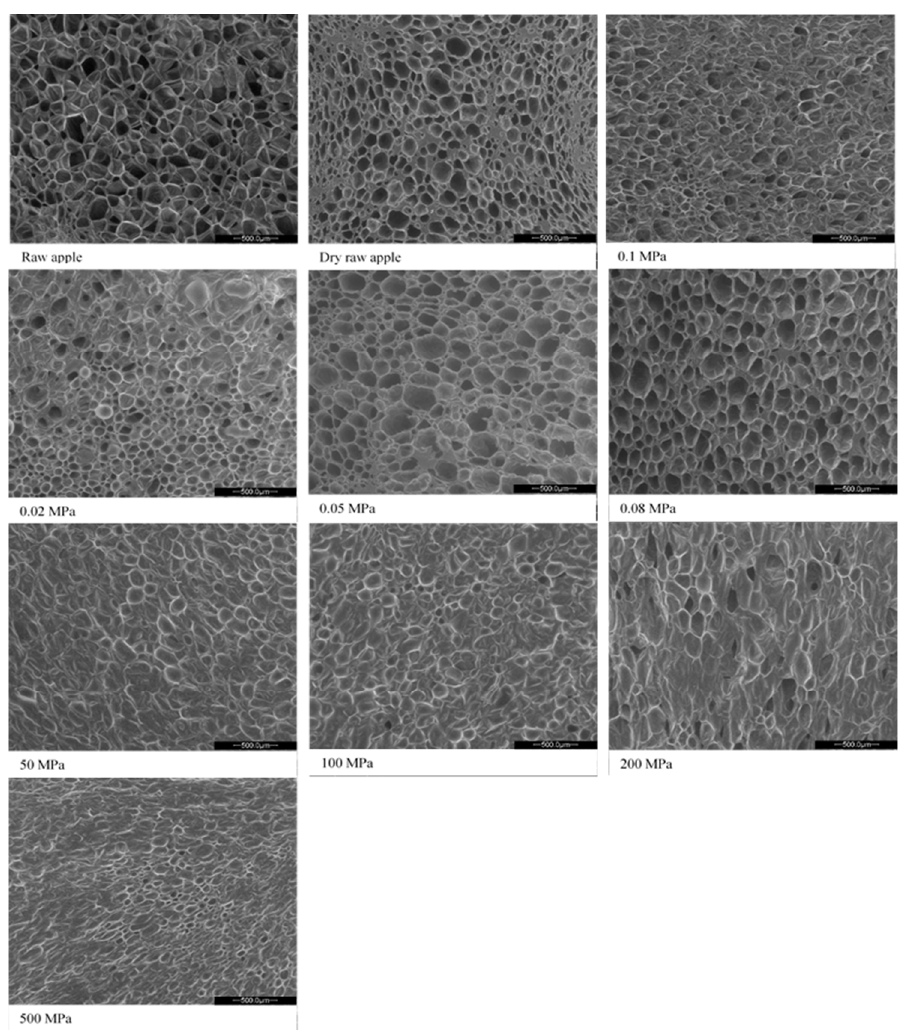
Figure 4. Structure of convectional dried apples non-dehydrated and osmotically dehydrated under lower than atmospheric pressure and higher than atmospheric pressure.